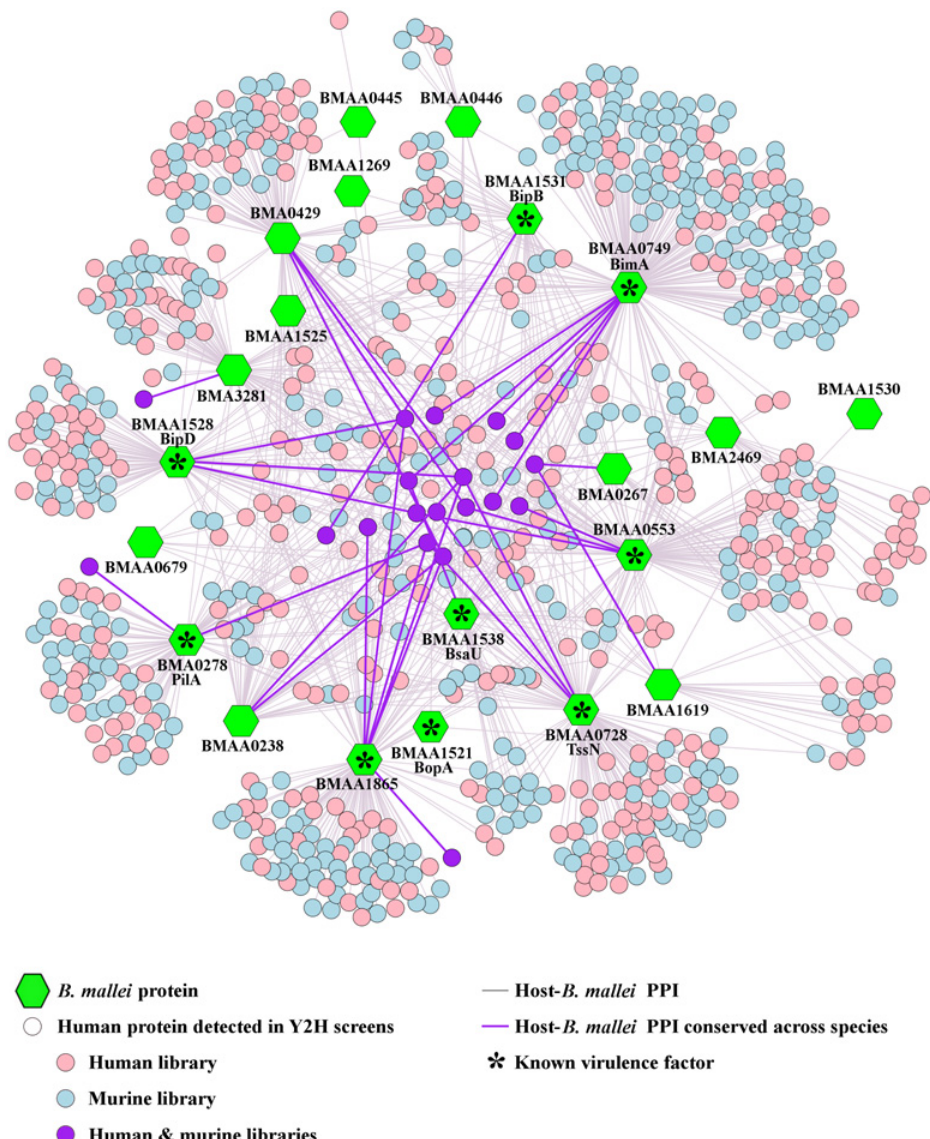
Fig 1. B. mallei -human host-pathogen protein interactions. The set of human- B. mallei protein-protein interactions (PPIs) was created by merging human- B. mallei and orthologous murine- B. mallei interaction data. The set consists of 1,235 unique interactions (gray and purple lines) between 21 B. mallei (green hexagons) and 828 human proteins (pink, blue, and purple circles). Known virulence factors are also indicated in the